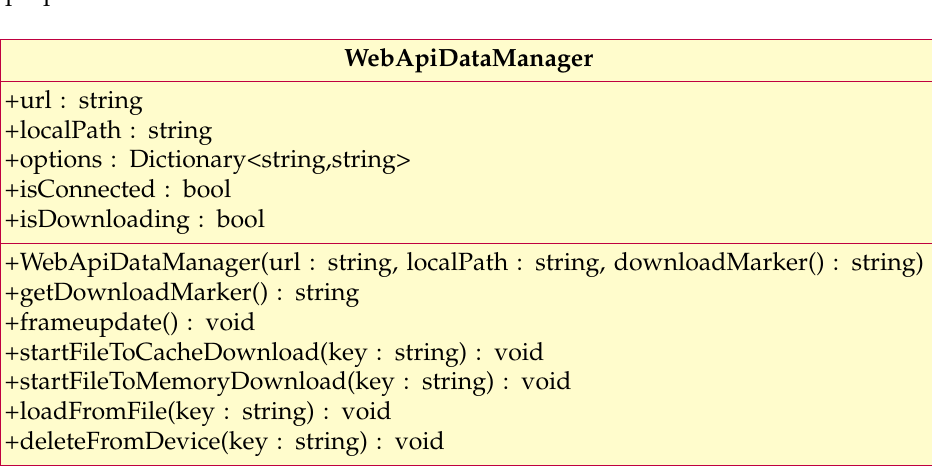
Figure 4. Class diagram of the WebApiDataManager with all essential functions and